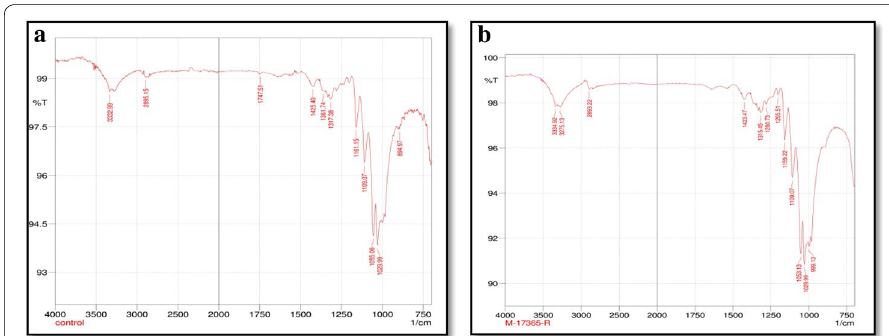
Fig. 8 ATR-FTIR images a control sample, b treated fabric with 0.5